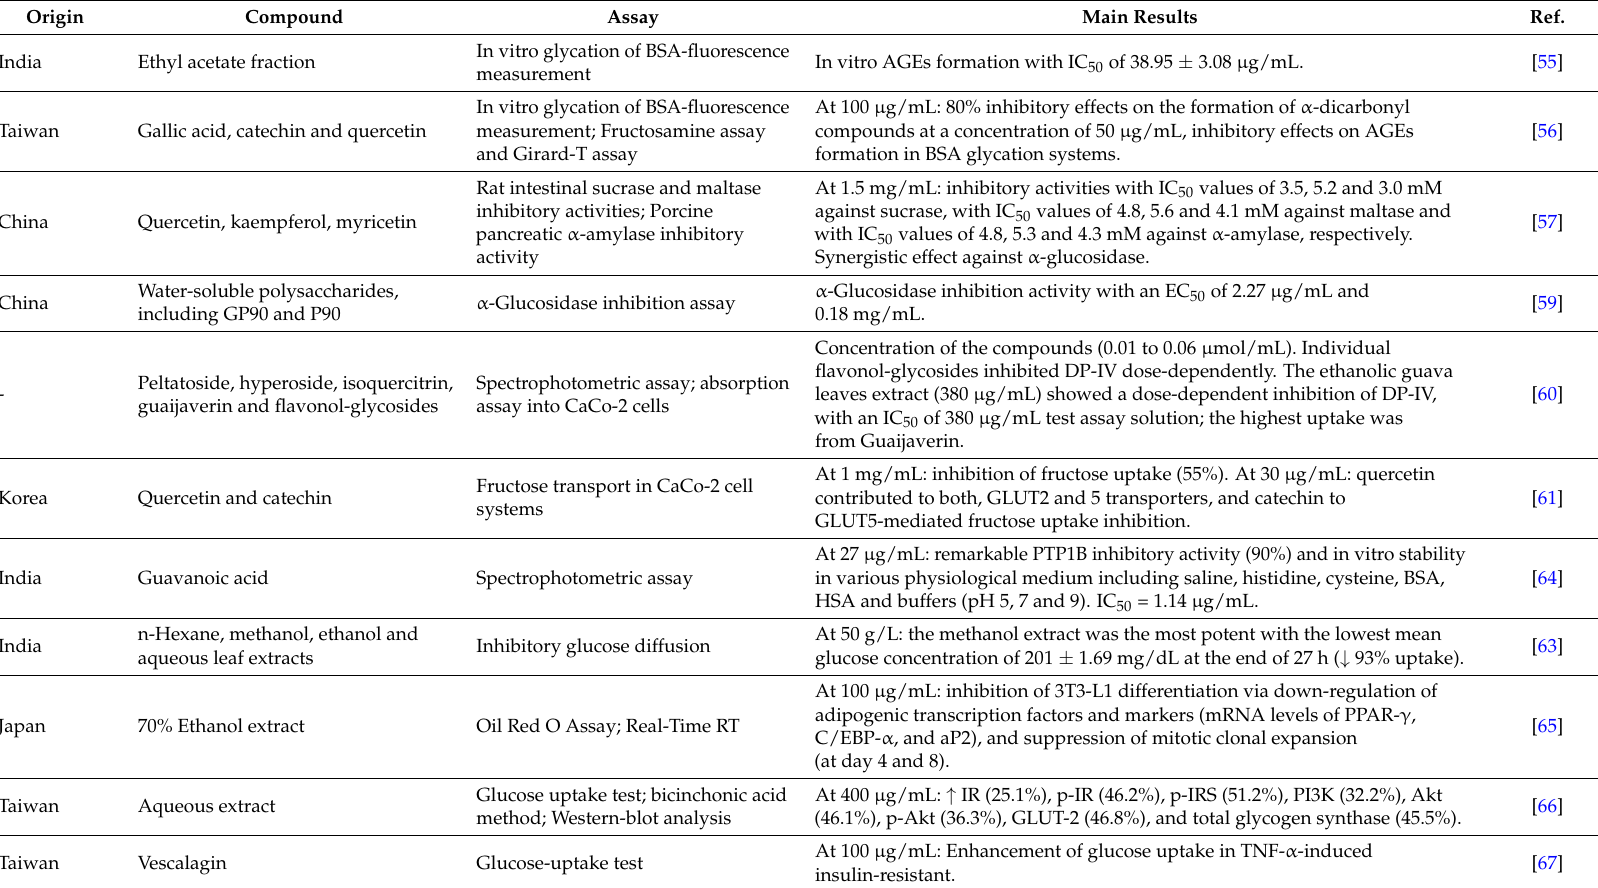
Table 4. Compounds in guava leaves with anti-diabetic properties in in vitro